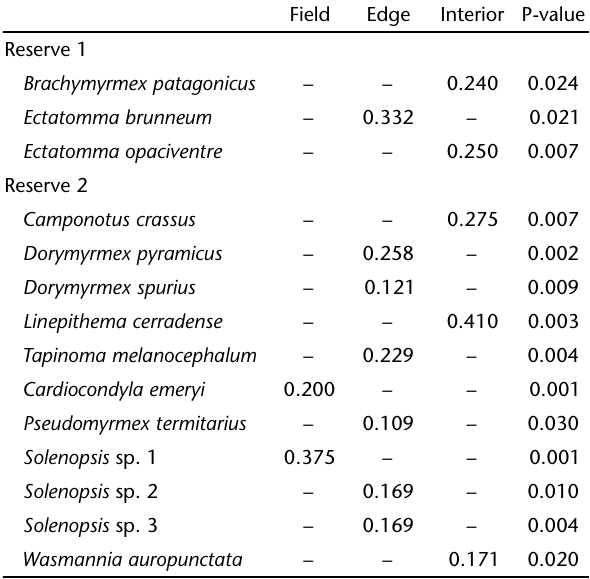
Table III. Indicator values for ground-dwelling ant species collected along transects set in the soy field (-100 and -50 m), Cerrado edge habitat (0 and 50 m) and Cerrado interior habitats (100, 150, 200, and 250 m) in Balsas, Maranhão, northern Brazil. Only the significant indicator species are included (p <